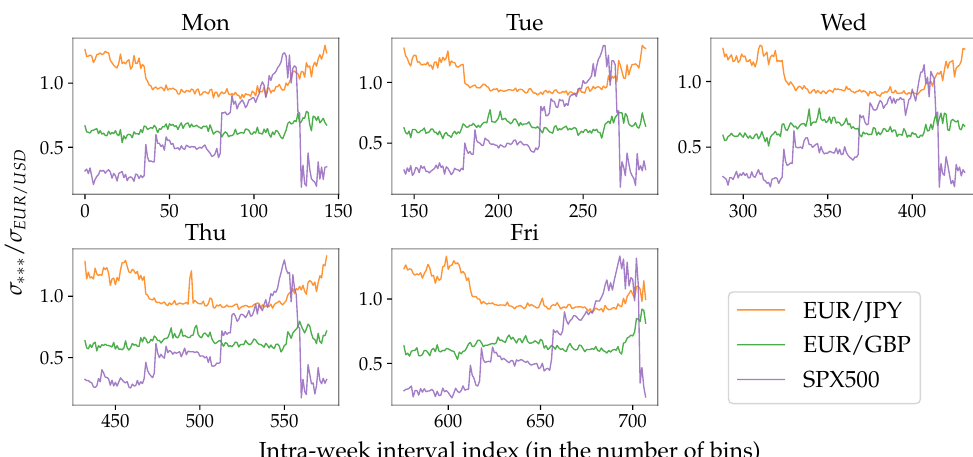
Figure A4. Daily instantaneous volatility ratio of the given exchange rates (labelled by ***) and EUR/USD. The volatility is computed according to the novel approach (Equation (19)). Table A1. Daily instantaneous volatility ratio and the weekly standard deviation of two FX (EUR/JPY and EUR/GBP), one crypto (BTC/USD), and one stock (SPX500) exchange rates to EUR/USD. Columns stands for the ratio of the average daily volatility of the corresponding exchange rate and one of Ratio ∗ EUR/USD. The average value computed over 10-min intervals. Columns std deviation values of the volatility ratio over the set of 10-min intervals. The subscripts trad and DC label the measures made using the traditional volatility estimator (Equation (20)) and the novel approach (Equation (19)) correspondingly. The daily volatility ratios are graphically presented in Figures A2 and